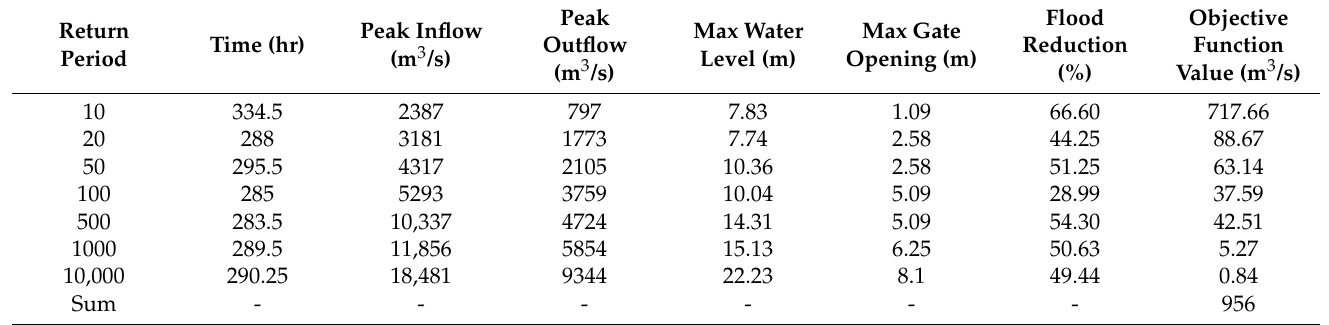
Table 5. Optimized results from simulated optimization model OP2 (genes, 100; population, 80; n =